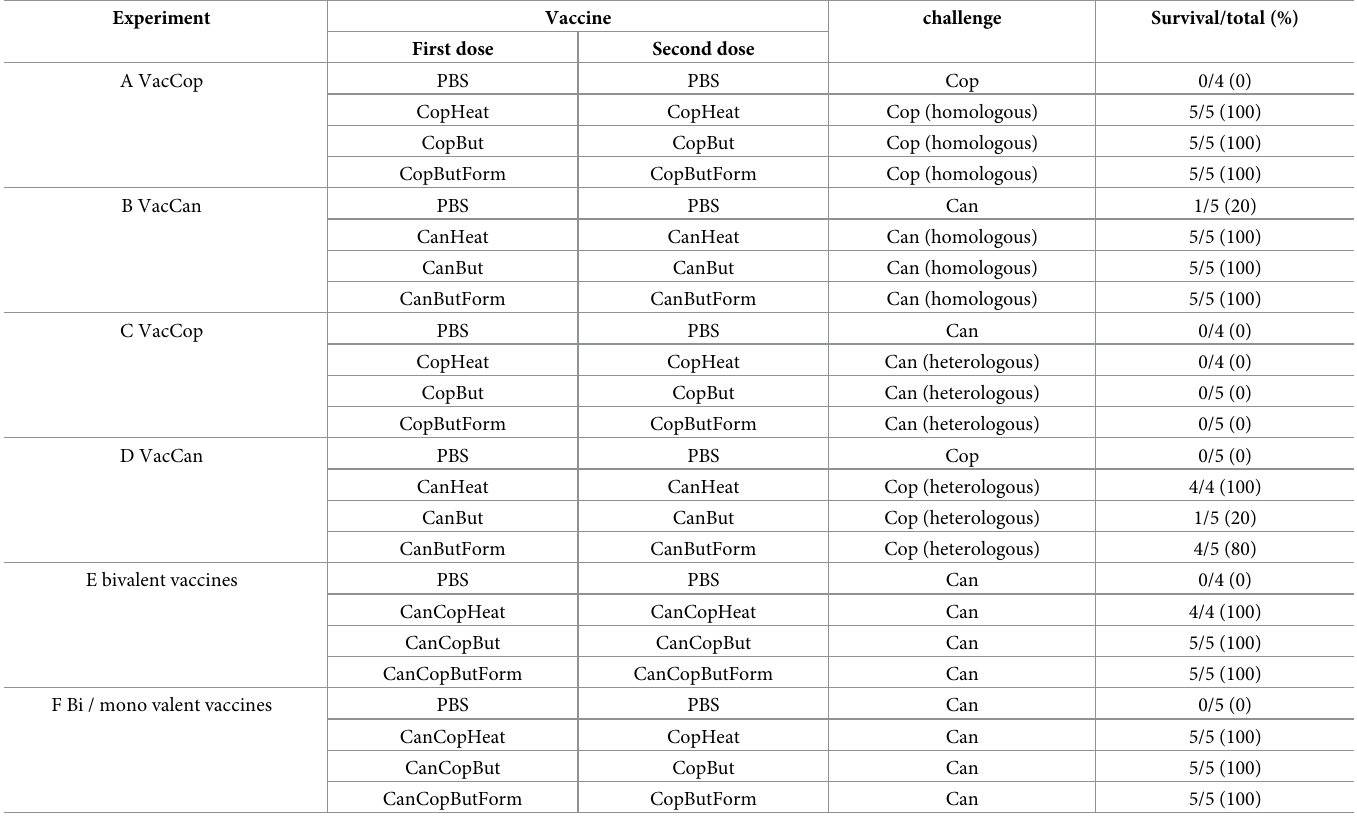
Table 2. Animal assays—experimental immunizations and challenge groups. Experiment Vaccine challenge Survival/total (%) First dose Second